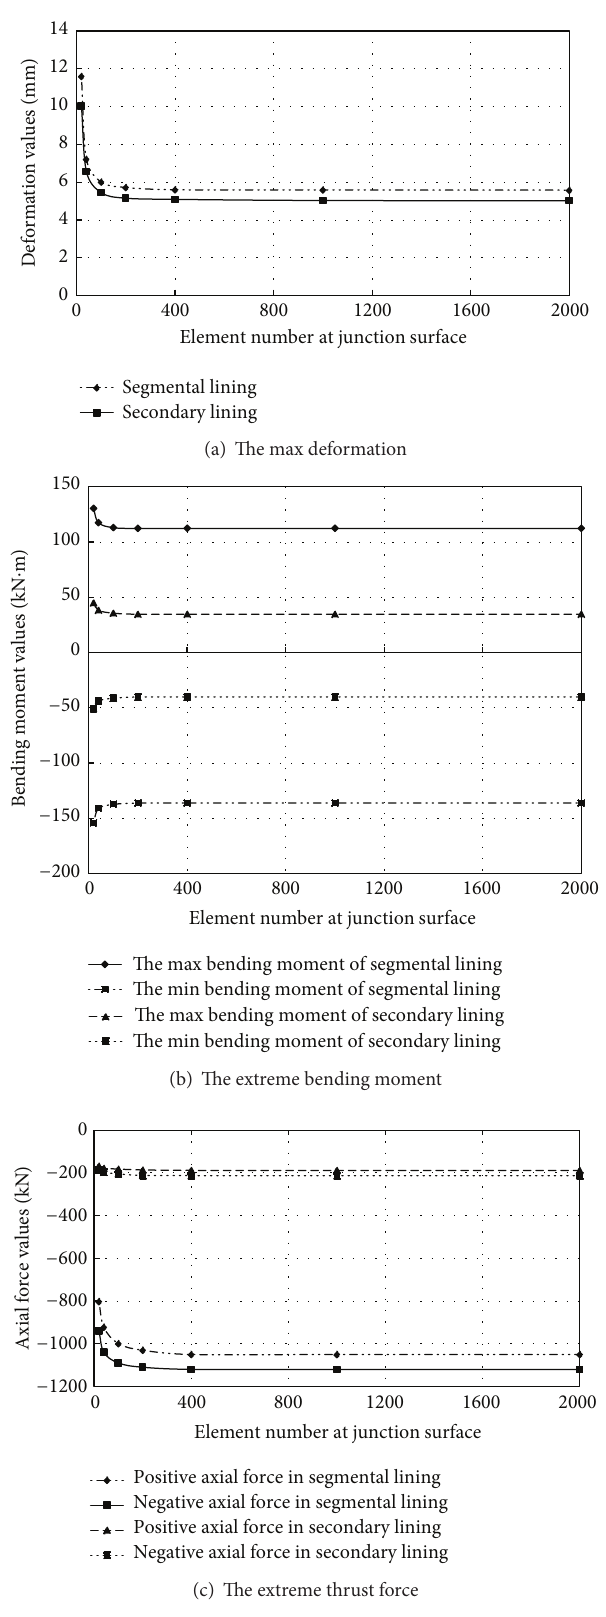
Figure 12: The influence of element number at junction surface on inner forces of double